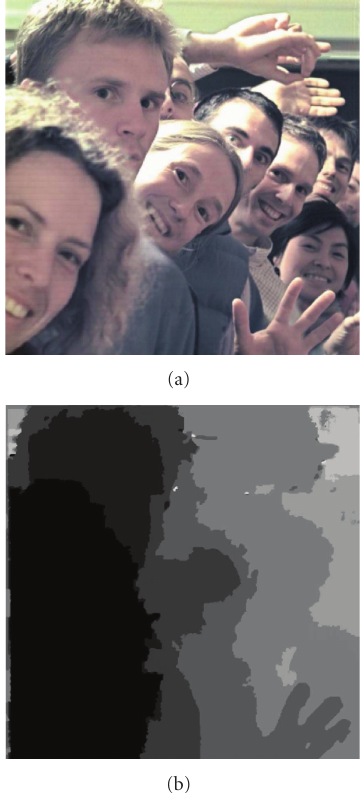
Figure 8: Super-resolved depth and all-in-focus